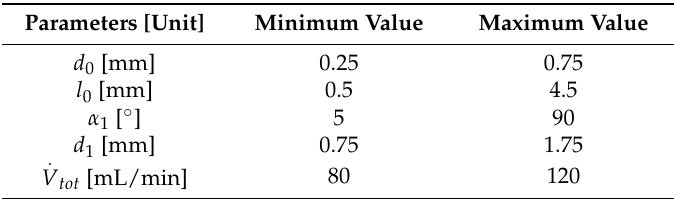
Table 2. Parameters included in the DoE with investigated value